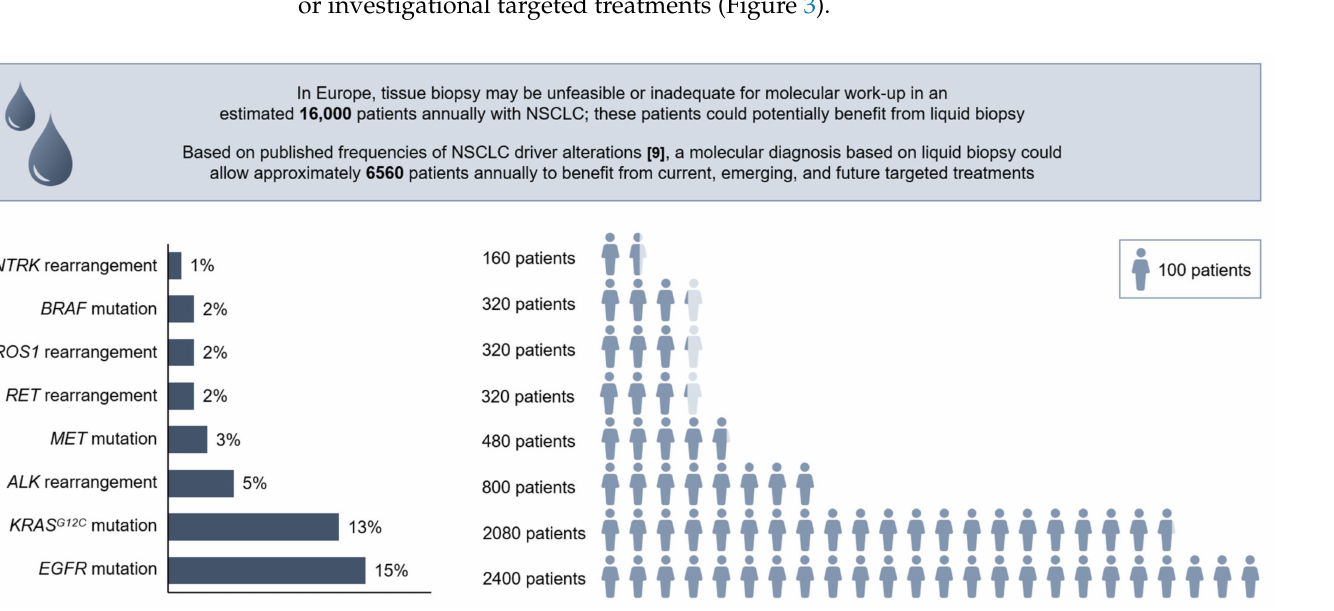
Figure 3. Estimated number of patients in Europe who could potentially benefit from liquid biopsy. Abbreviations: ALK , anaplastic lymphoma kinase; BRAF , B-Raf proto-oncogene; EGFR , epidermal growth factor receptor; KRAS , Kirsten rat sarcoma viral oncogene homolog; MET , hepatocyte growth factor receptor; NSCLC, non-small cell lung cancer; NTRK , neurotrophic tyrosine receptor kinase; RET , rearranged during transfection; ROS1 , ROS proto-oncogene